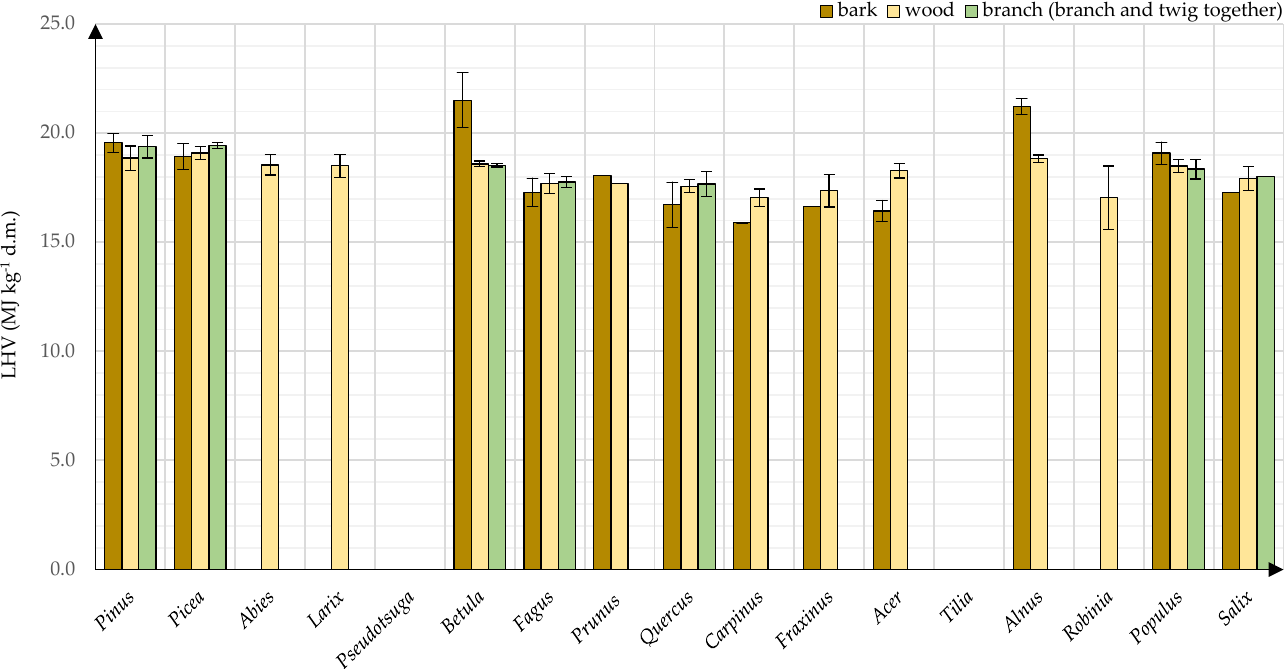
Figure 7. Average value and average deviation of the LHV of organs of particular systematic genera trees.